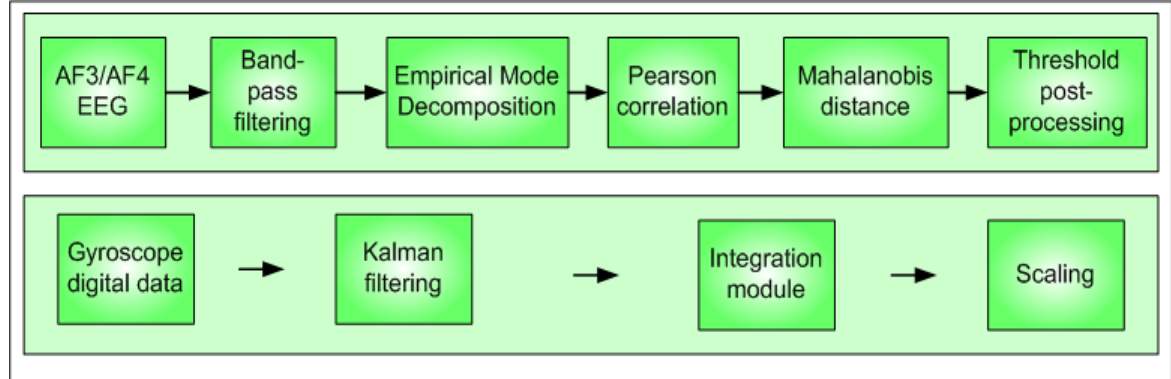
Figure 3. Proposed scheme, blinking detection and gyroscope processing